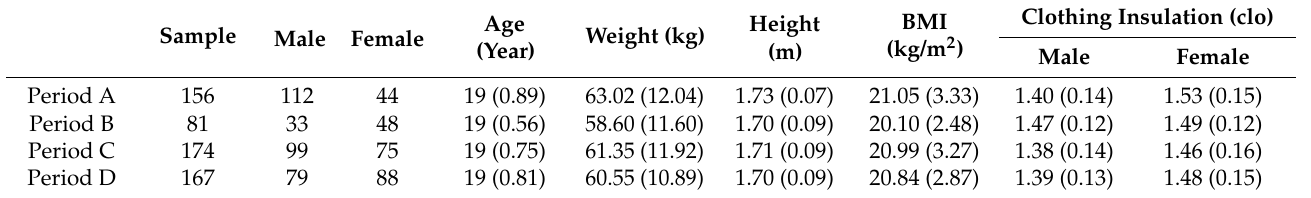
Table 3. Mean demographics and clothing insulation of questionnaire